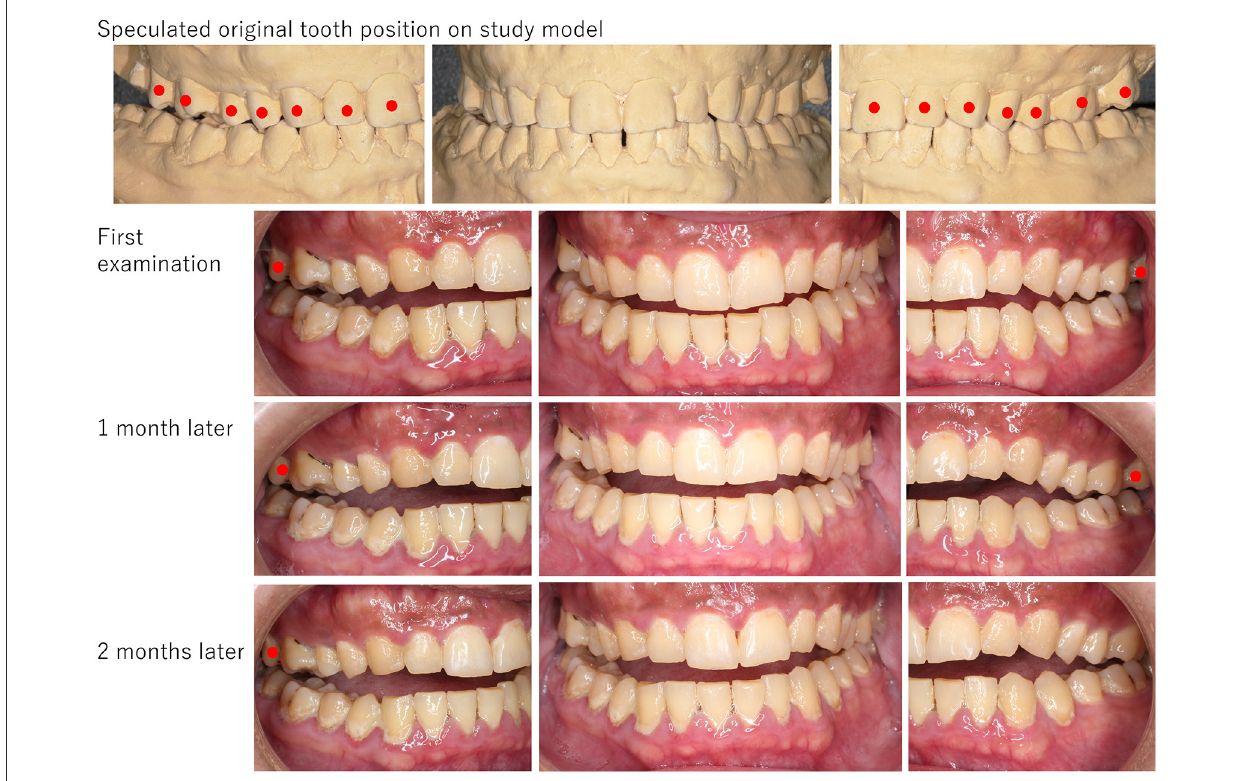
FIGURE4 The picture of a patient (Case No. 10). Open bite was obvious, and occlusal contact was observed only on the second molars. Tight occlusal contact was found on the left premolars to right molars on his study model, but partially on the right molars. Drug-induced open bite had never changed during 2 months of follow-up. Red circles indicate teeth that have occlusal